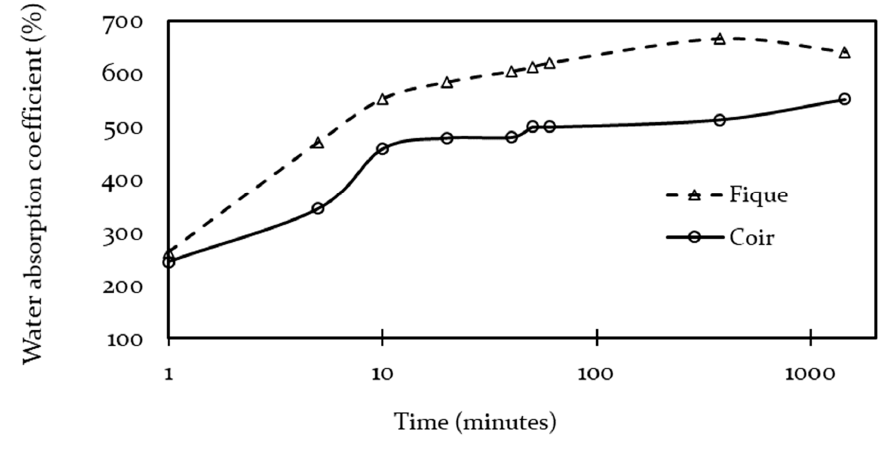
Figure 9. Panel water absorption